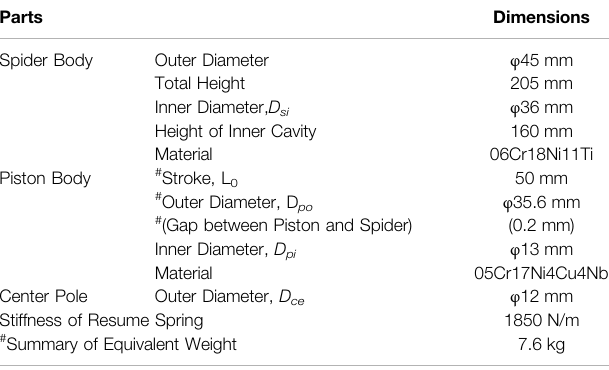
TABLE 1 | Key dimensions of spider hydraulic buffer.